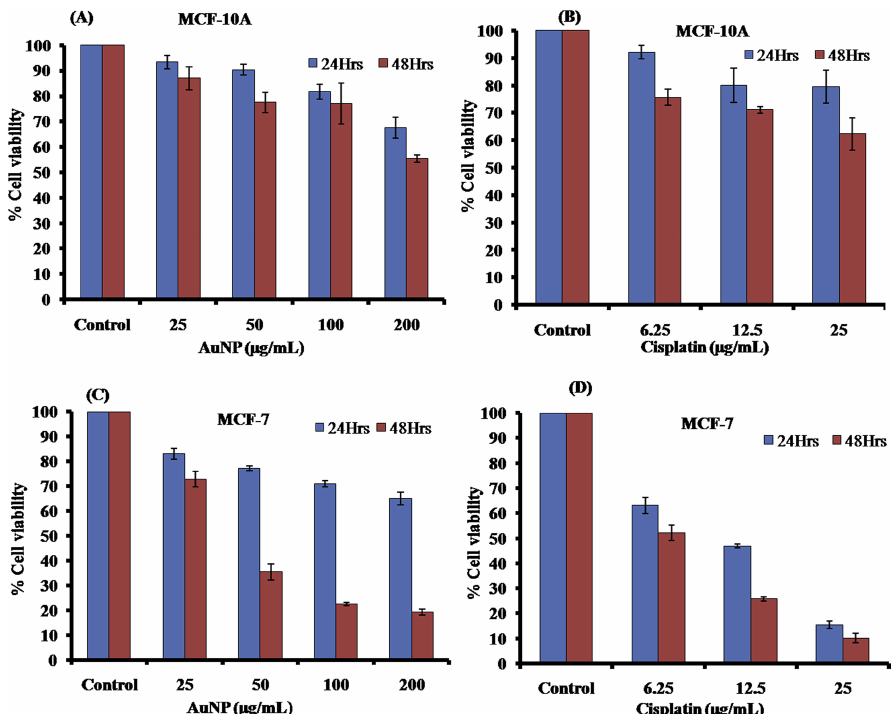
Figure 8. Cell viability using MTT assay after treatment with AuNPs and cisplatin on MCF 10A ( A , B ) and MCF 7 cell lines ( C , D ). Reprinted with permission from Ref. [109]. Copyright 2019